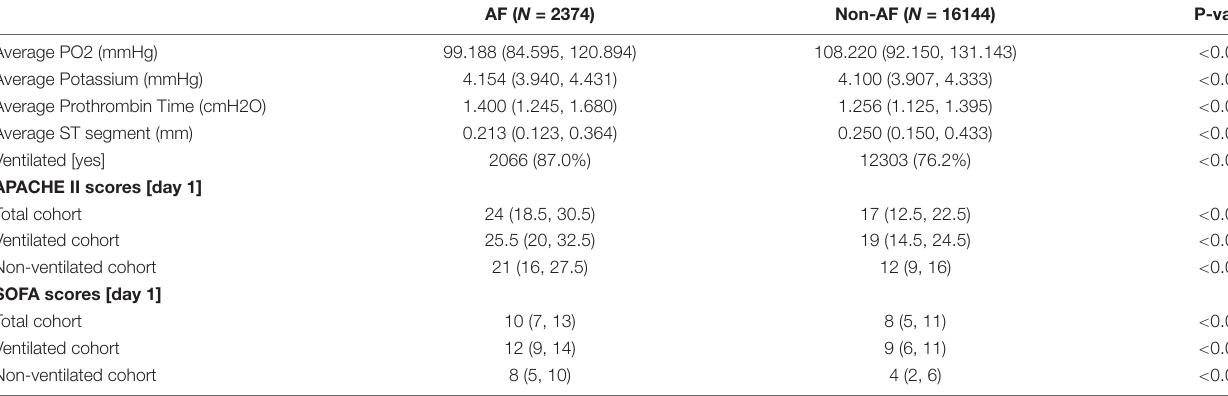
algorithm using 3-fold cross-validation. The selection